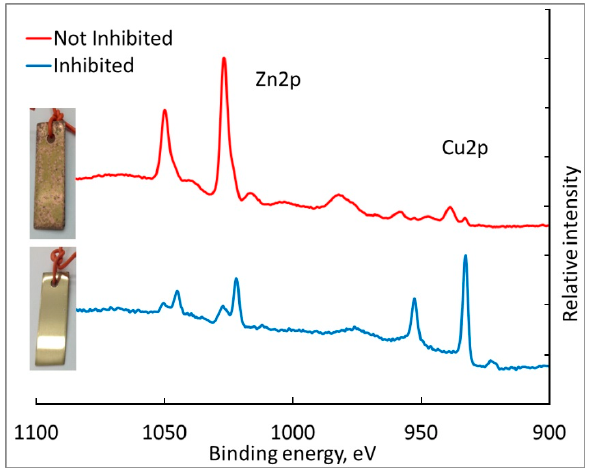
Figure 11. Composition of brass surface by XPS after corrosion tests in salt fog chamber.